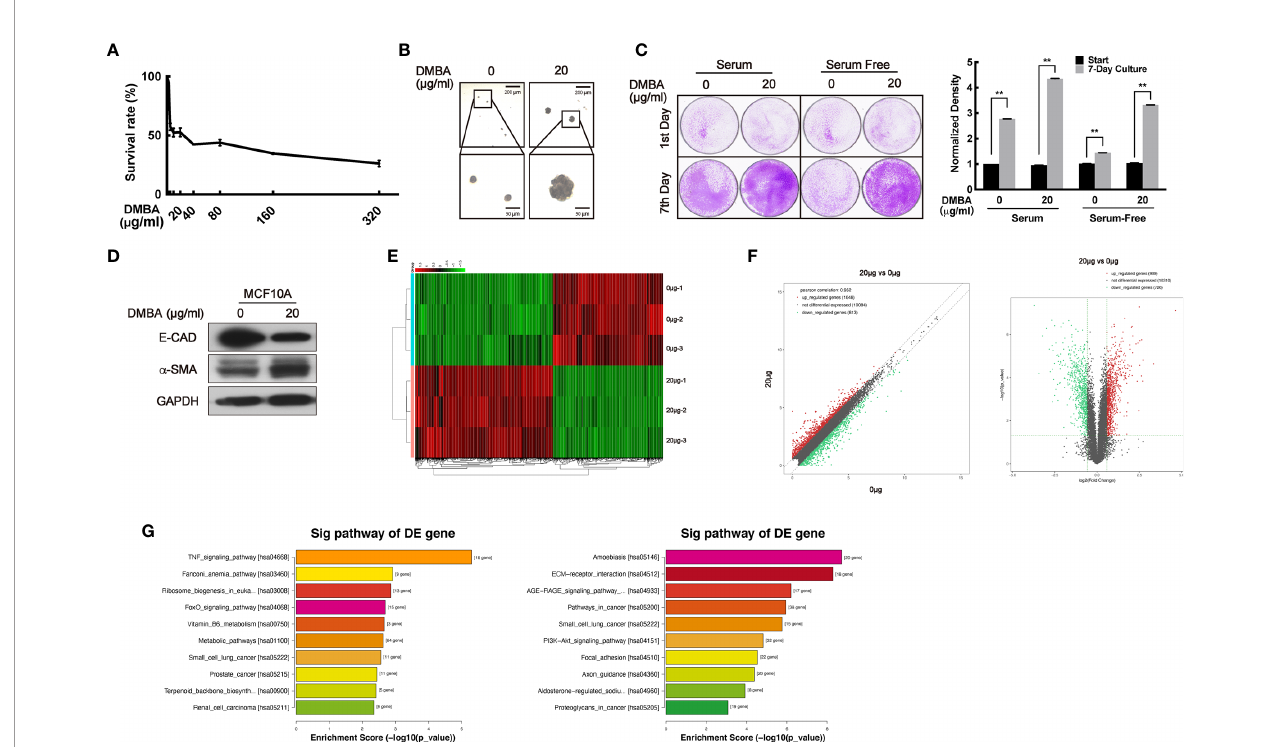
FIGURE 1 | The establishment of a DMBA-induced malignant transformation cell model on normal cell MCF10A. (A) MTT assay was performed for the toxicity detection of DMBA on MCF10A. (B) Soft agar assay showed the forming colonies after 4 weeks of culturing to identify cell transforming. (C) Cells were cultured under different serum conditions to detect their growth ability to identify cell transforming. (D) The expression of E-CAD and a -SMA was detected by Western blot both on 0 and 20 m g/ml DMBA-treated MCF10A cells. (E) The heat map from RNA sequencing analysis showed the differentially expressed genes between 20 and 0 m g/ml DMBA-treated cells. (F) Scatter plot (left) and volcano plot (right) exhibited the changed-genes between the two cell lines. (G) Genes were analyzed by KEGG database for clustering functional pathways, enrichment score was used as the measurements. Each data point in the graph was from three independent experiments (mean ± SD); P -values were calculated by t-test (** P <